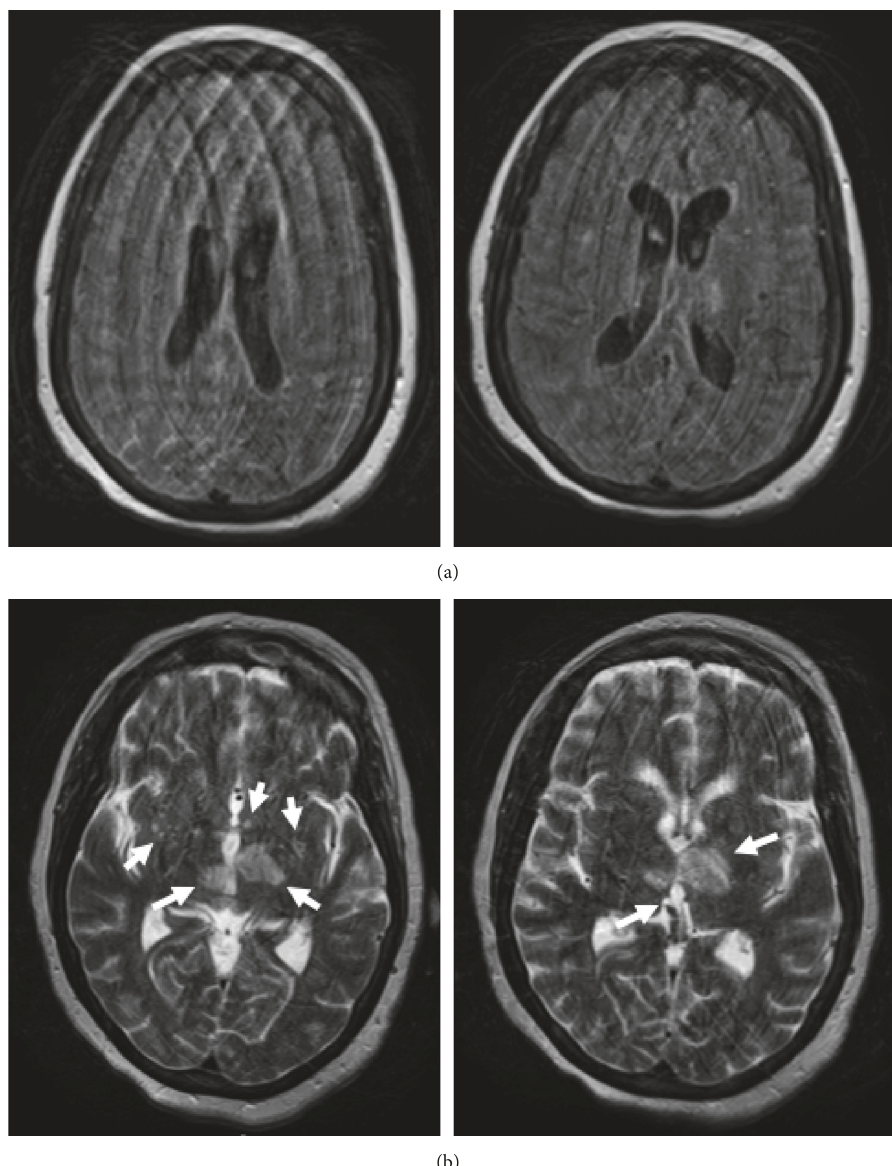
Figure 4: Repeat MRI of the brain on hospital day 10. (a) There is much less FLAIR enhancement of the ventricles, consistent with improving infection. (b) T2 weighted images showing several new infarcts within the bilateral thalami, basal ganglia, and right parietal lobe (arrows). Also visible are older, evolving